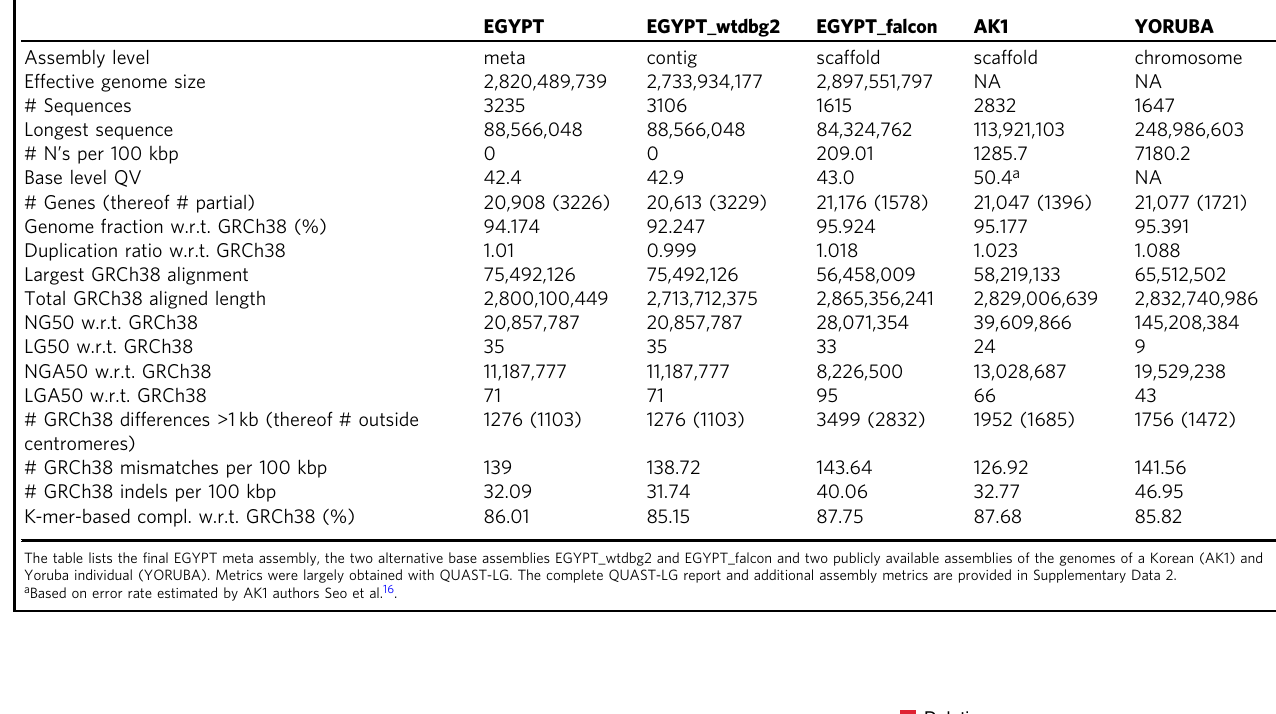
Table 1 Comparison of main assembly characteristics and quality metrics.